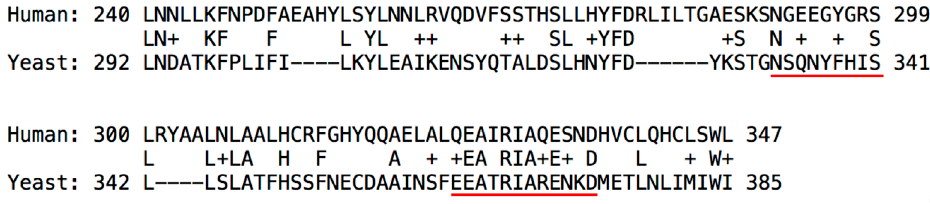
Figure 4. Levels of conservation of amino acids modeled as displaying interactions between human Cdc20-Apc5 and human Cdc20-Apc1. ( A ) In Apc1, the core potential interacting region is at the amino acid motif 1236-LPPTSTLDV-1244, which corresponds to the budding yeast amino acid motif of 1110-LPSGSSDLNI-1119 (red underline). In human Apc1, there is a cluster of serine and two threonines that display the modeled interactions, which corresponds to cluster of three serines in yeast Apc1. The structural similarity between serine and threonine may be important for the interaction with asparagine N119 from Cdc20. ( B ) In APC/C without MCC bound, the Apc5 core potential regions are at the amino acid motifs of 291-NGEEGYGRS-299, which corresponds to the budding yeast amino acid motif of 333-NSQNYFHIS-341 (red underline). Although the alignment places the human tyrosine Y296 together with phenylalanine F338, it should be noted there is an adjacent tyrosine at Y337 that may be involved in any potential interaction with Cdc20 in yeast. In APC/C with MCC bound, in addition to the modeled interaction with tyrosine Y296, there is a seconded modeled interaction with glutamic acid E333, where the core human amino acid motif is 325-QEAIRIAQESND-336, which corresponds to the budding yeast amino acid motif of 363-EEATRIARENKD-374 (red underline).